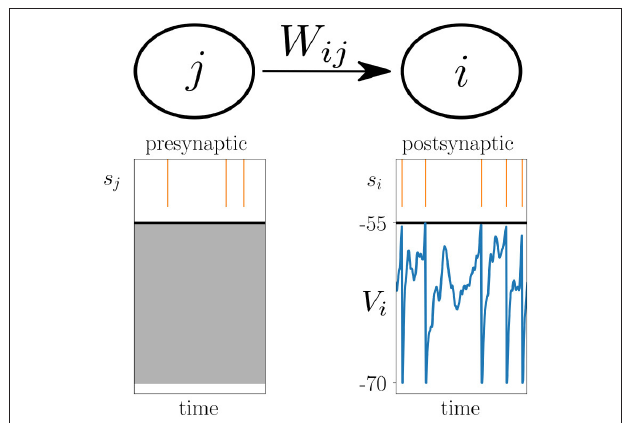
FIGURE 2 | Voltage-based plasticity rules. The change 1 W ij in synaptic strength between presynaptic neuron j and postsynaptic neuron i depends on the presynaptic spike train s j , the postsynaptic spike train s i and the postsynaptic membrane potential V i .